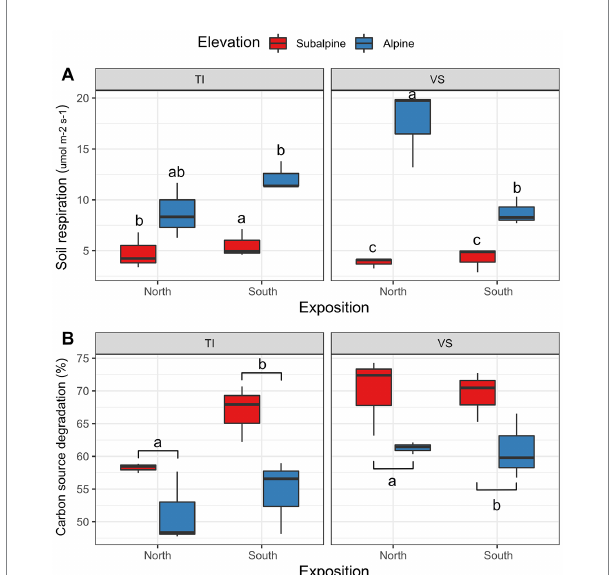
FIGURE 4 Soil respiration and microbial activity. Shown is (A) Boxplots representing average soil respiration (Licor bioassay), and (B) average soil carbon degradation (EcoPlates bioassay) values at each site separated by exposition (North versus South facing slopes), and regions (Ticino = TI, or Valais = VS ). Letters above boxplots represent significant differences among main effects (Tuckey’s post-hoc tests; p < 0.05). Red color (warm) represents the sub-alpine zone (~1,400 m above sea level), and blue color (cold) represents the alpine zone (~2000 m above sea level). N = 3 plots per